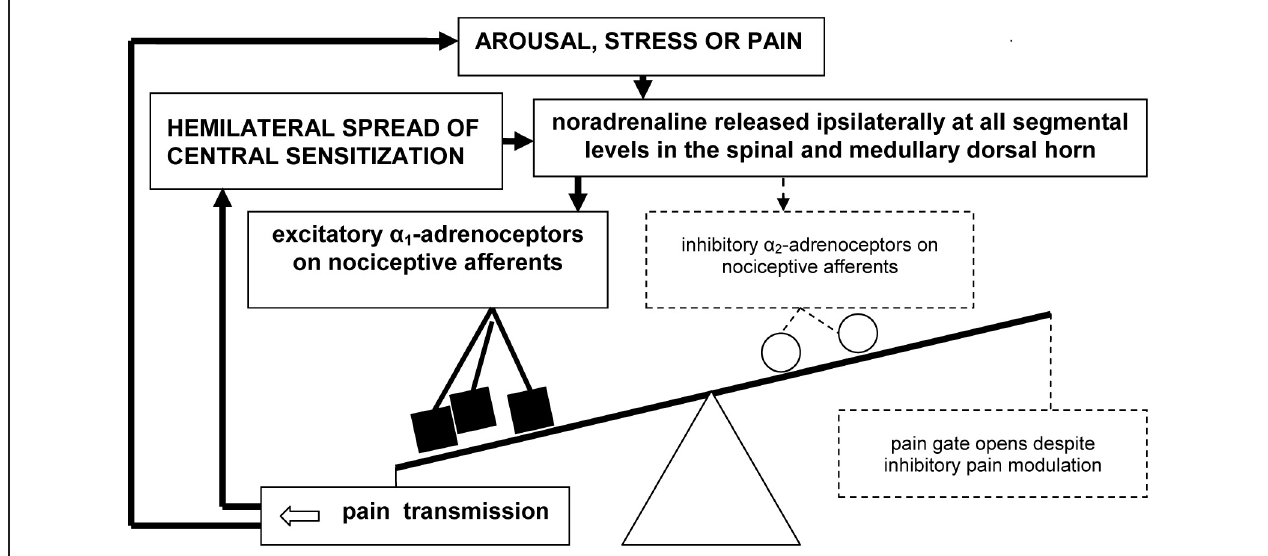
FIGURE 2 | A vicious cycle involving up-regulated α 1 -adrenoceptors on primary nociceptive afferents may overwhelm inhibitory spinal pain modulation in CRPS and certain other chronic neuropathic pain syndromes, resulting in pain escalation and emotional distress.